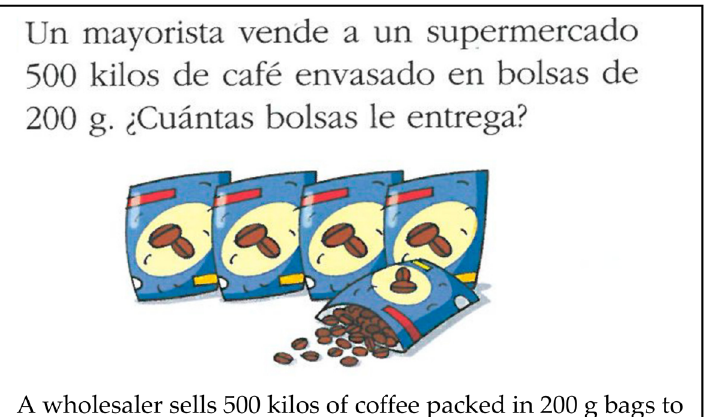
Figure 10. Example of occupational context task (fifth year mathematics, Anaya [50]).